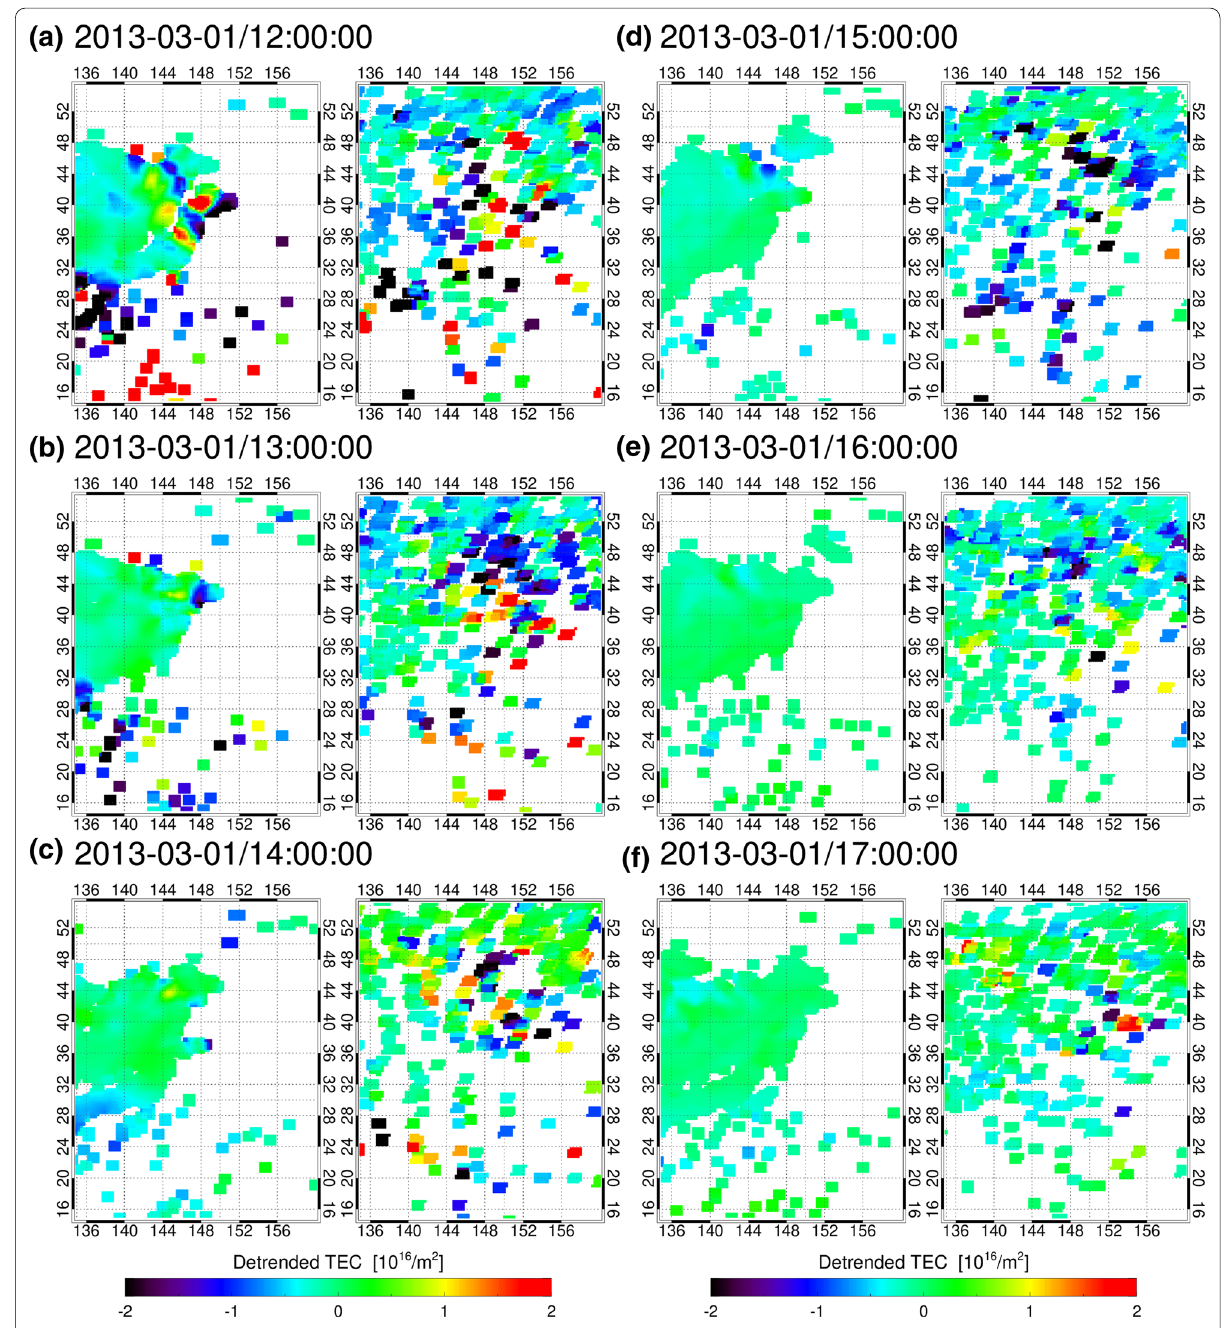
Fig. 6 Same as Fig. 5, but for the detrended TEC. The color code indicates the detrended TEC value within a range of